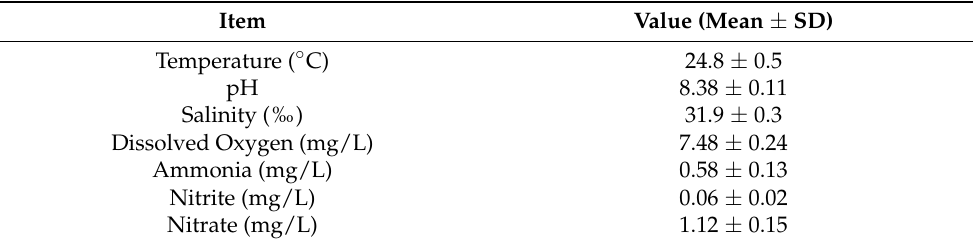
Table 2. The chemical components of seawater and experimental condition used in the experiments.